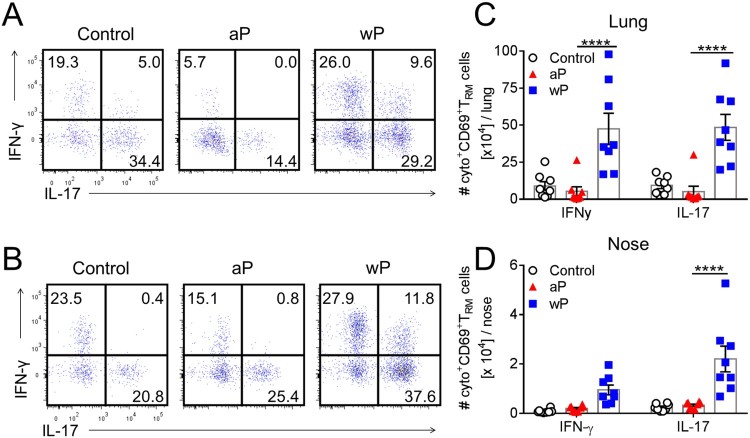
CD69+CD4+ TRM cells induced in the lungs and nasal tissue by immunization with a wP vaccine potently secreted IFN-γ and IL-17. C57BL/6 mice were immunized and challenged, and tissue-resident cells were quantified as described in Figure 1. Representative FACS plots and total number of IFN-γ- and IL-17-secreting CD69+CD4+ TRM cells in the lungs (a) and nasal cavity (b) 7 days post challenge. (c, d) Absolute numbers of IFN-γ or IL-17-producing CD69+CD4+ TRM cells in the lung (c) or nasal tissue (b). Results shown are mean ± SEM (n = 8 mice in two independent experiments). ****p < .0001 versus aP by two-way ANOVA with the Tukey’s post-test, only significant differences between experimental groups are indicated.